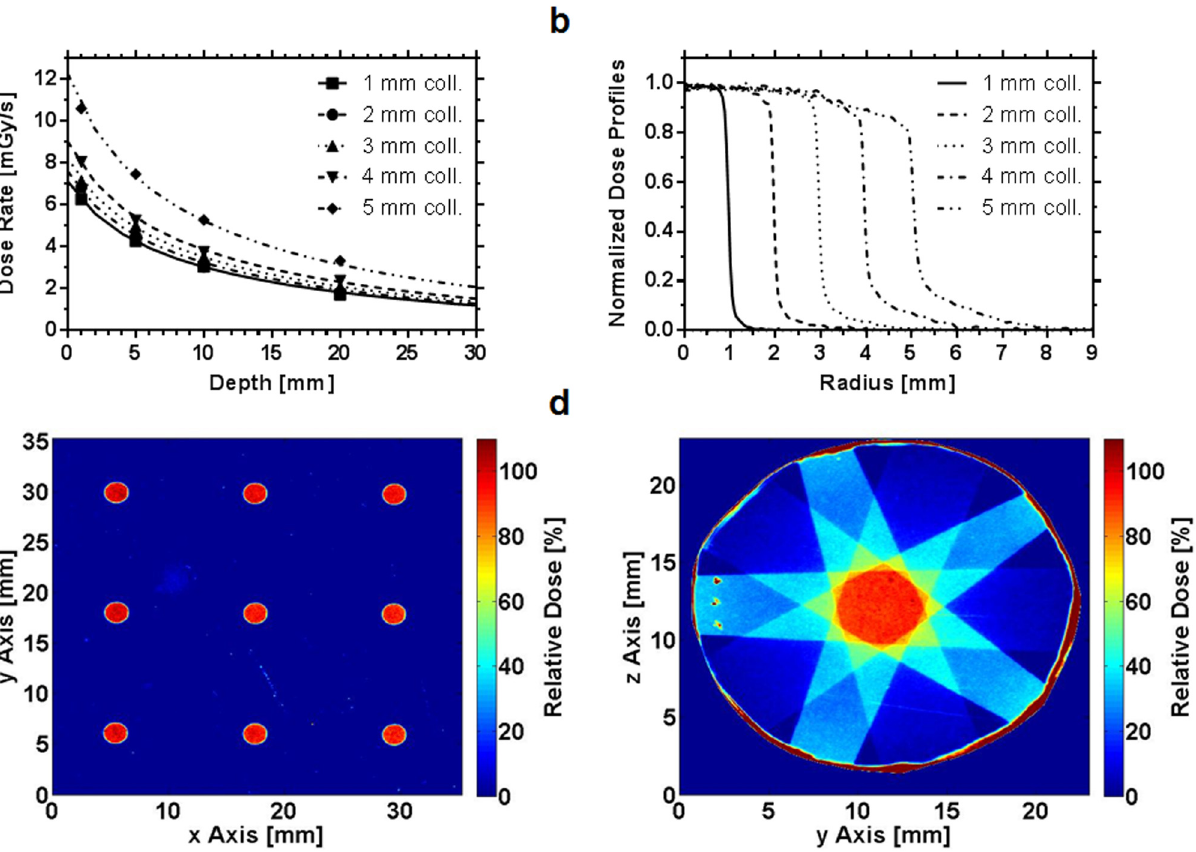
Fig 1. Dosimetric characteristics and reproducibility of the system. (a) Measured data and fitted curves (S3 Text, Eq. (1)) of depth-dose rates. Mean values of three measurements in various depths using all established collimators (aperture sizes 1 – 5 mm) are shown. (b) Radial dose profiles of the five collimators in 1 mm depth. (c) Accuracy assessment of the manipulator in the x-y-plane. A quadratic pattern was produced and the distances between the spots were measured. (d) Assessment of center of rotation accuracy. A pentagon pattern (right side) was used to assess the angle accuracy of the CNC arm.